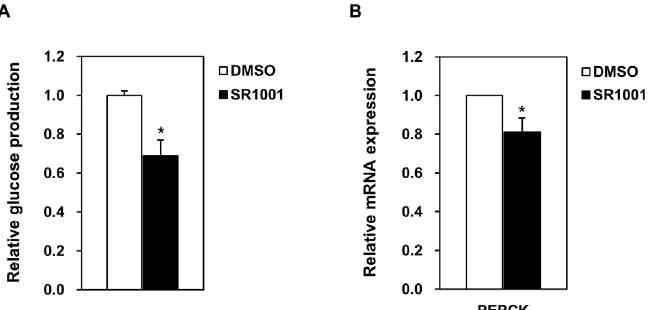
Fig 6. In vitro gluconeogenesis is suppressed by a ROR α antagonist. (A) Glucose production in HepG2 cells incubated for 4 h in 10 μ M SR1001, a ROR α antagonist, or in DMSO. (B) Effect of 10 μ M SR1001 on PEPCK mRNA expression in HepG2 cultures 7 h after treatment. Data are mean ± S.E. of triplicate experiments. * , p <